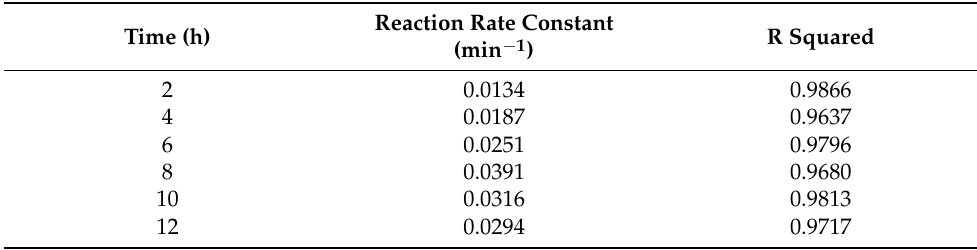
Table A2. Reaction rate constants and R-squared values calculated for substrates with different silver nanoparticle deposition